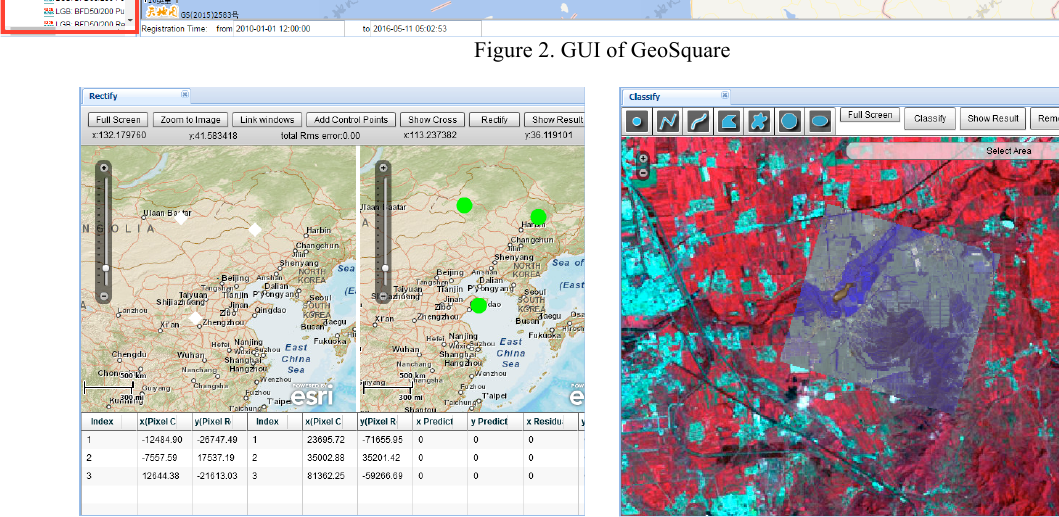
Figure 2. GUI of